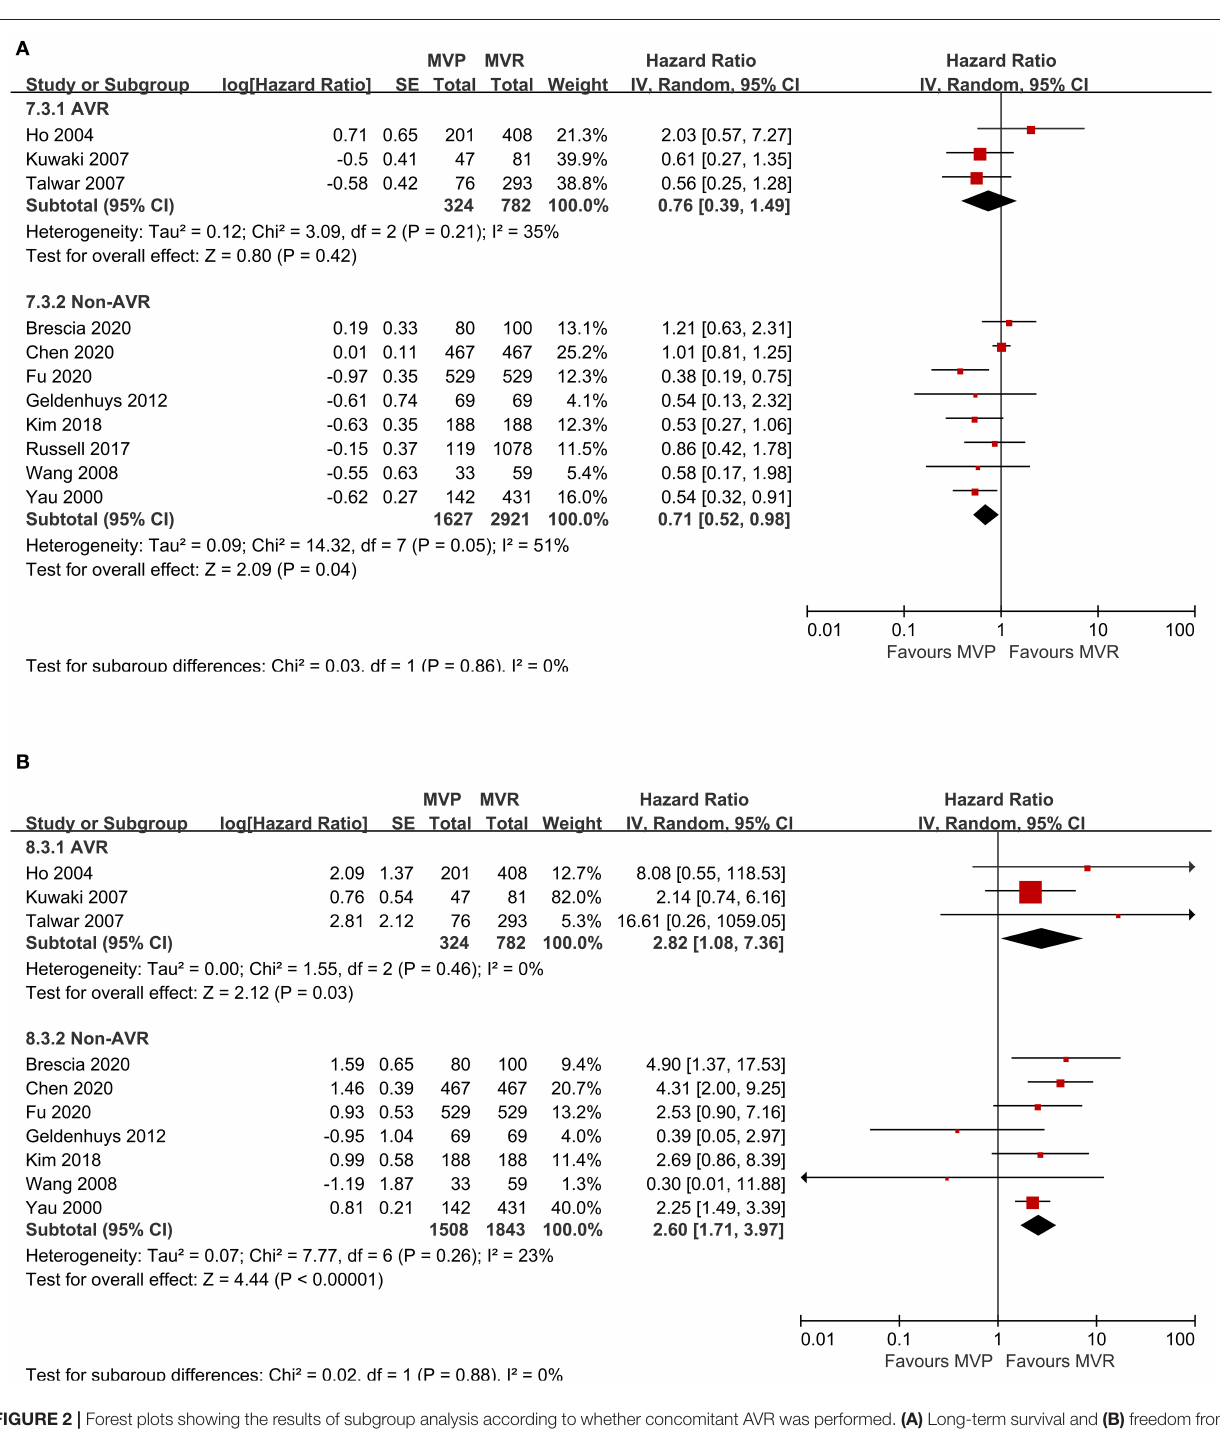
FIGURE 2 | Forest plots showing the results of subgroup analysis according to whether concomitant AVR was performed. (A) Long-term survival and (B) freedom from reoperation. MVP, mitral valve repair; MVR, mitral valve replacement; AVR, aortic valve replacement; IV, Inverse-Variance; CI, confidence interval; SE, standard